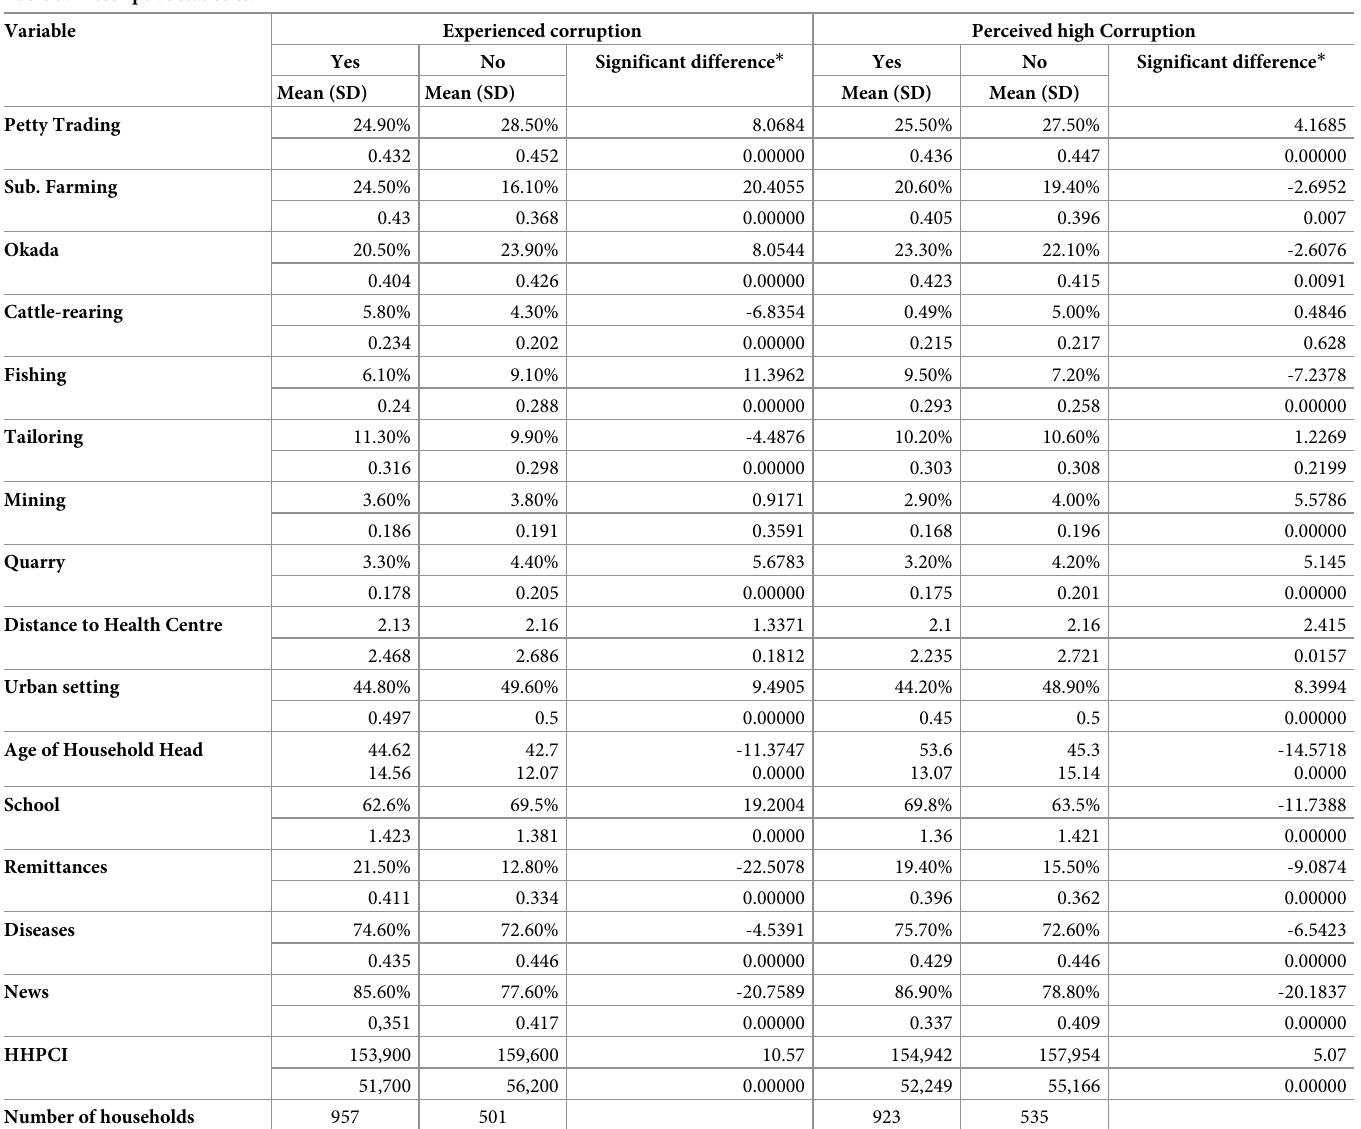
Table 3. Descriptive